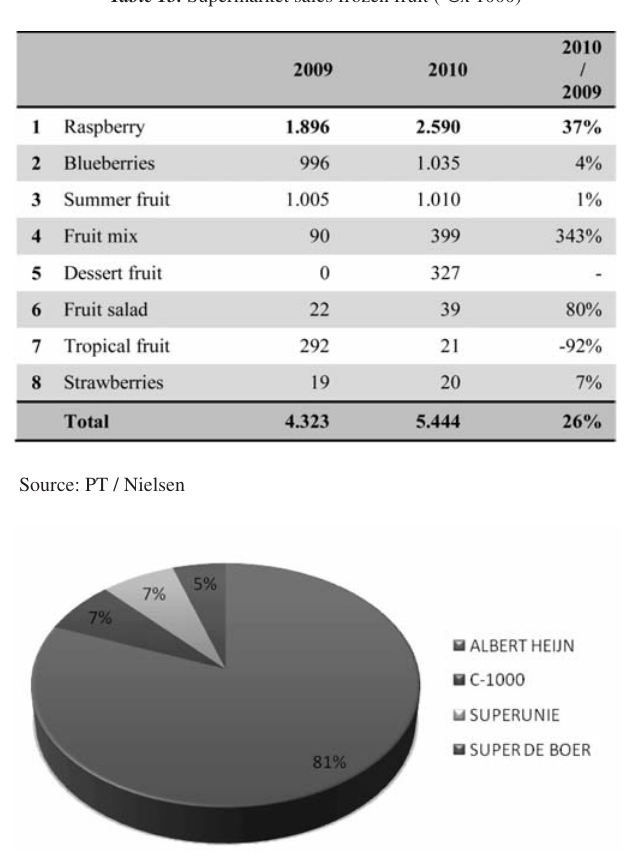
Table 13. Supermarket sales frozen fruit ( € x 1000)